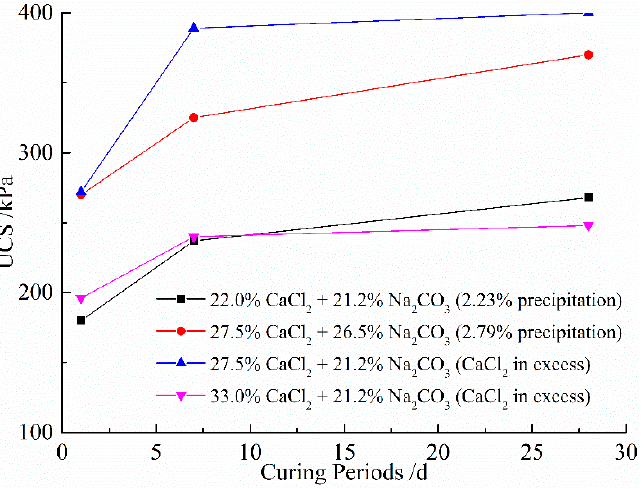
Figure 5. Variations of UCS with different concentrations of solutions versus curing periods.